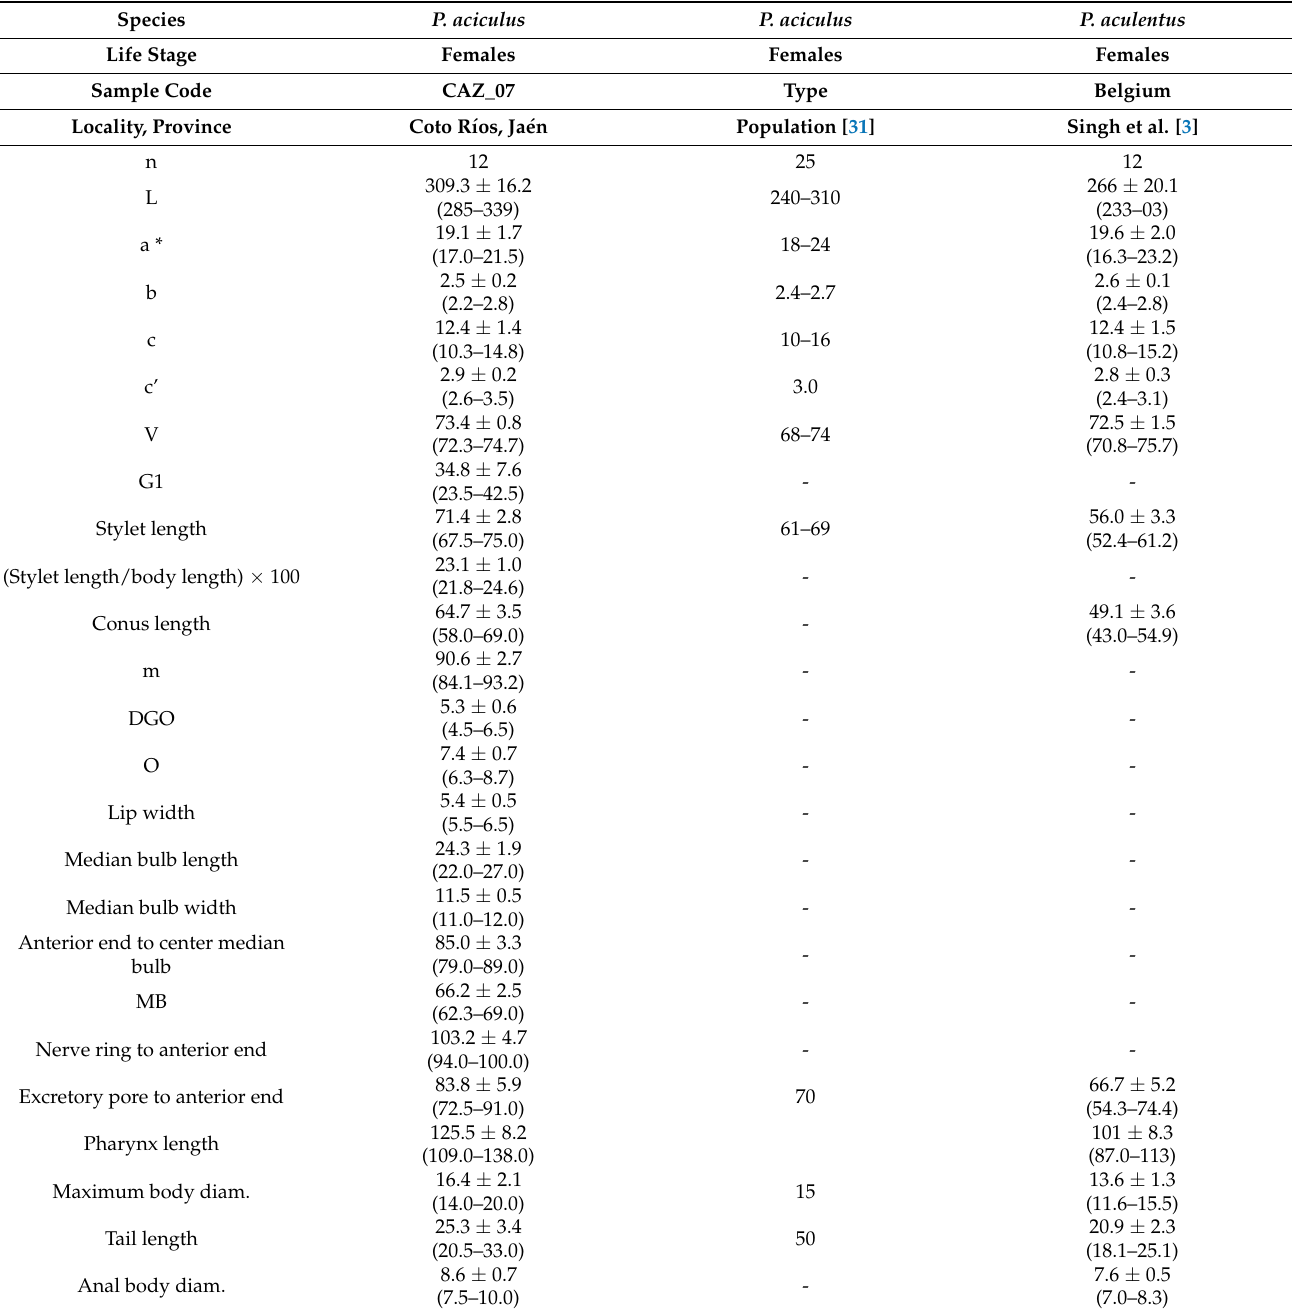
Table 3. Morphometrics of Paratylenchus aciculus Brown, 1959 from Coto R í os, Ja é n, Spain, type population, and P. aculentus from Belgium. All measurements are in µ m and in the form: mean ± s.d. (range). Species P.